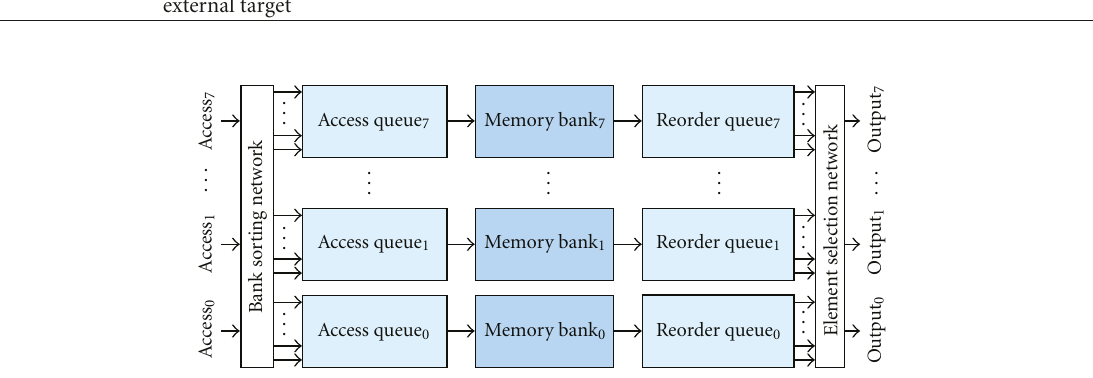
Figure 2: Conflict resolving